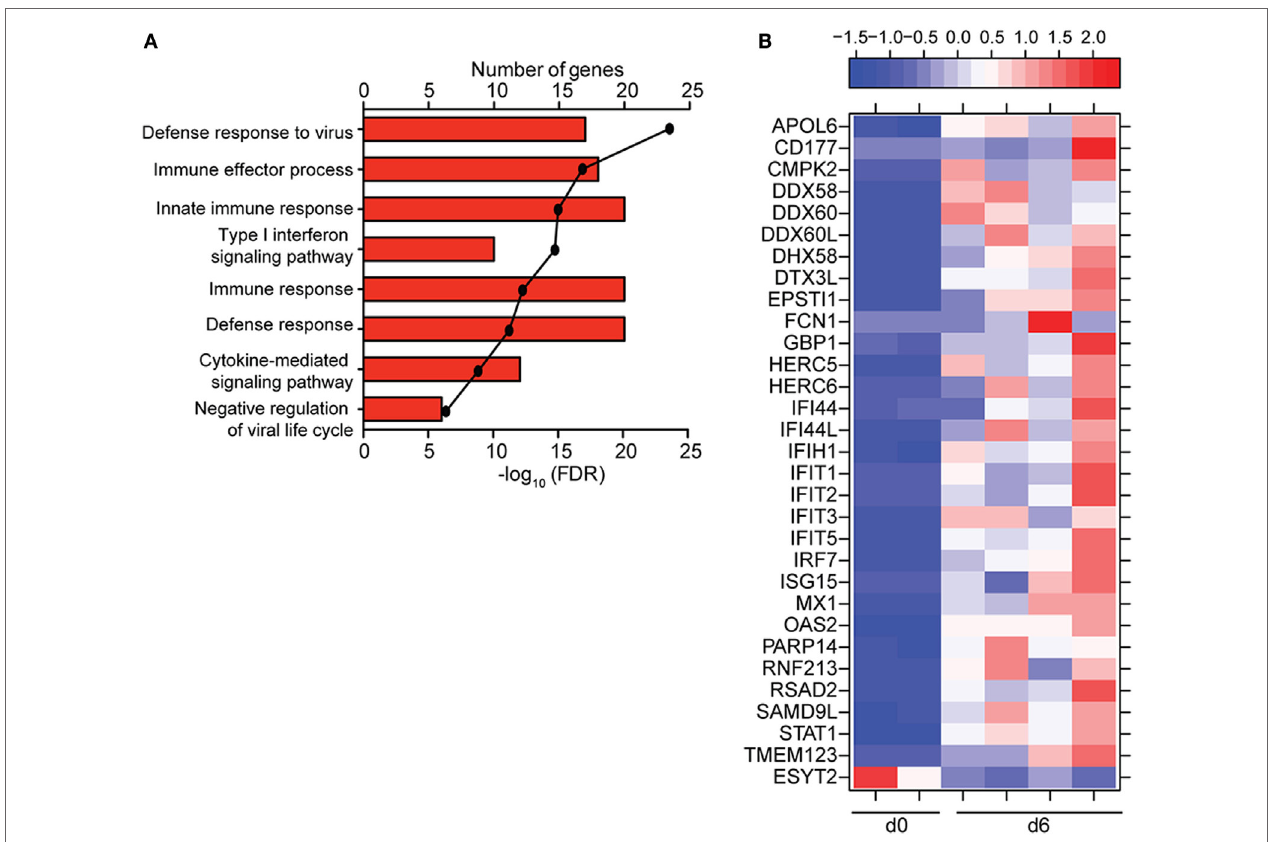
FigUre 5 | ZEBOV-Makona infection induces limited differential gene expression in B-cells. (a) Functional enrichment of upregulated genes detected 6 DPI; horizontal bar graphs represent number of genes that mapped to each Gene Ontology term listed while line graph represents false discovery rate (FDR)-corrected p -value. (B) Heatmap representing gene expression (shown as absolute normalized RPKM values) of all differentially expressed genes 6 DPI; range of colors is based on scaled and centered RPKM values of the entire set of genes (red represents increased expression while blue represents decreased expression); each column represents 1